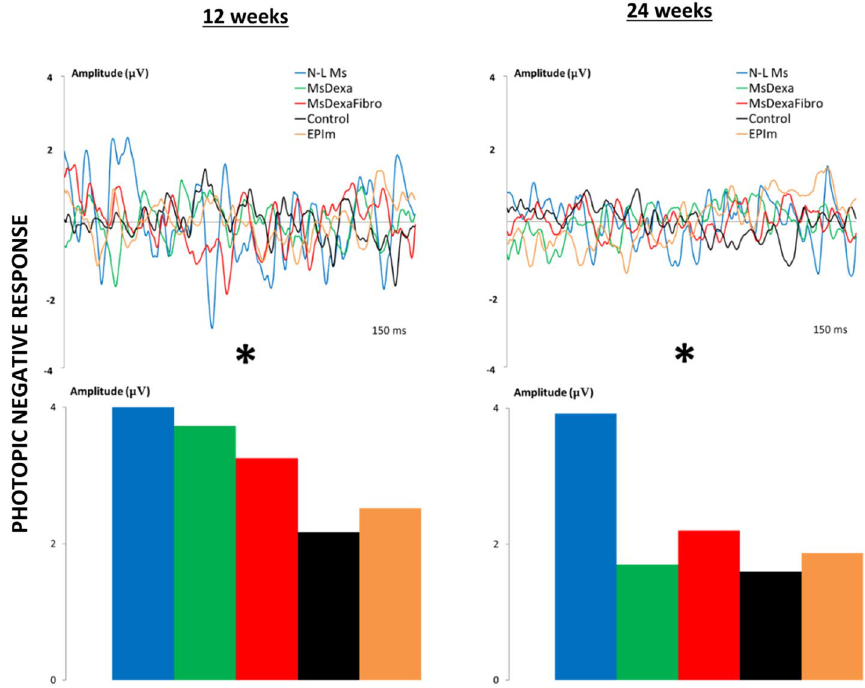
Figure 9. Follow-up comparison of neuroretinal function using light-adapted electroretinography between four chronic glaucoma models and healthy control cohorts. Photopic negative response test. Retinal ganglion cell functionality increased in all glaucoma models at middle times explored. N-L Ms cohort with non-loaded microspheres; MsDexa cohort with microspheres loaded with dexamethasone; MsDexaFibro cohort with microspheres loaded with dexamethasone and fibronectin; EPIm cohort with sclerosis of the episcleral veins. *: statistical significance ( p < 0.05) between glaucoma models and healthy controls